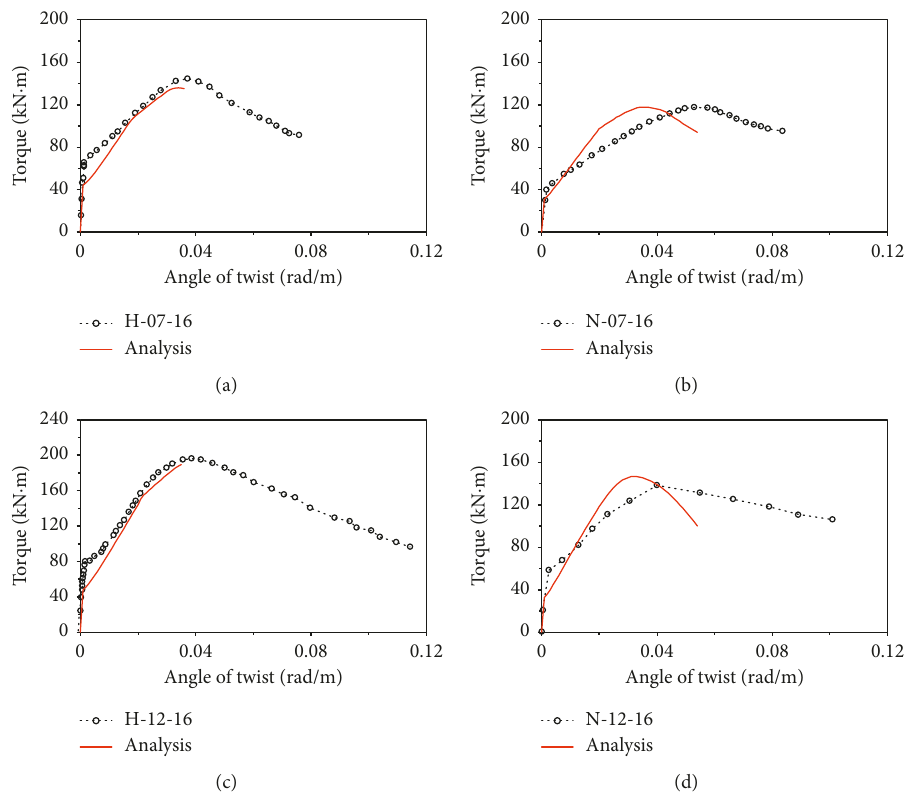
Figure 14: Analysis and test results comparison for beam 3: (a) H-07-16, (b) H-12-16, (c) N-07-16, and (d)